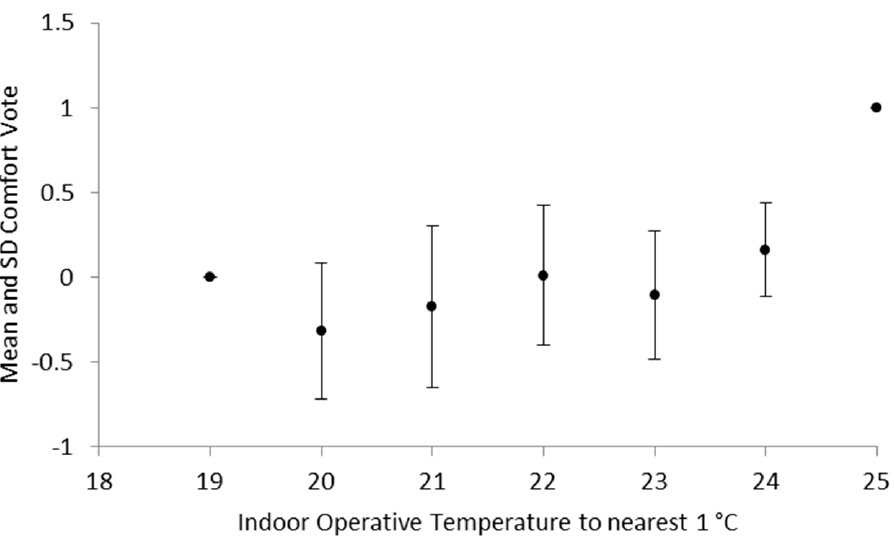
Figure 9. Error bars showing the variation of mean comfort vote with one degree “bins” of operative temperature. The circles are the mean comfort vote and the lines indicate the variation around them. There is no variation at 19 °C and 25 °C because there is only one comfort vote reported at those temperatures.